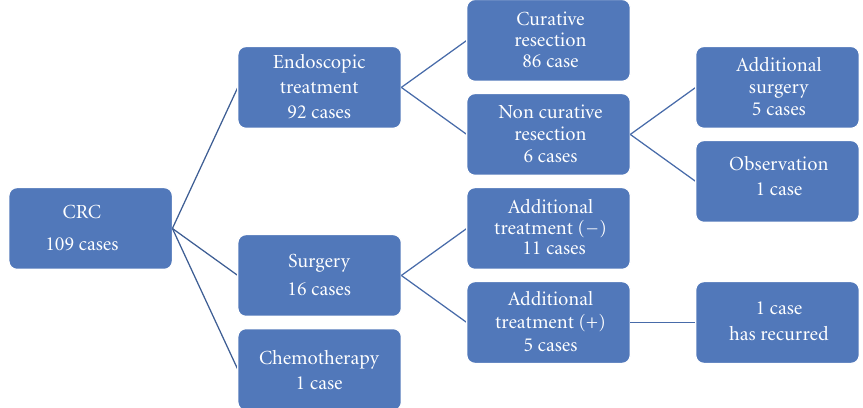
Figure 1: The clinical course of CRC cases detected in strategy